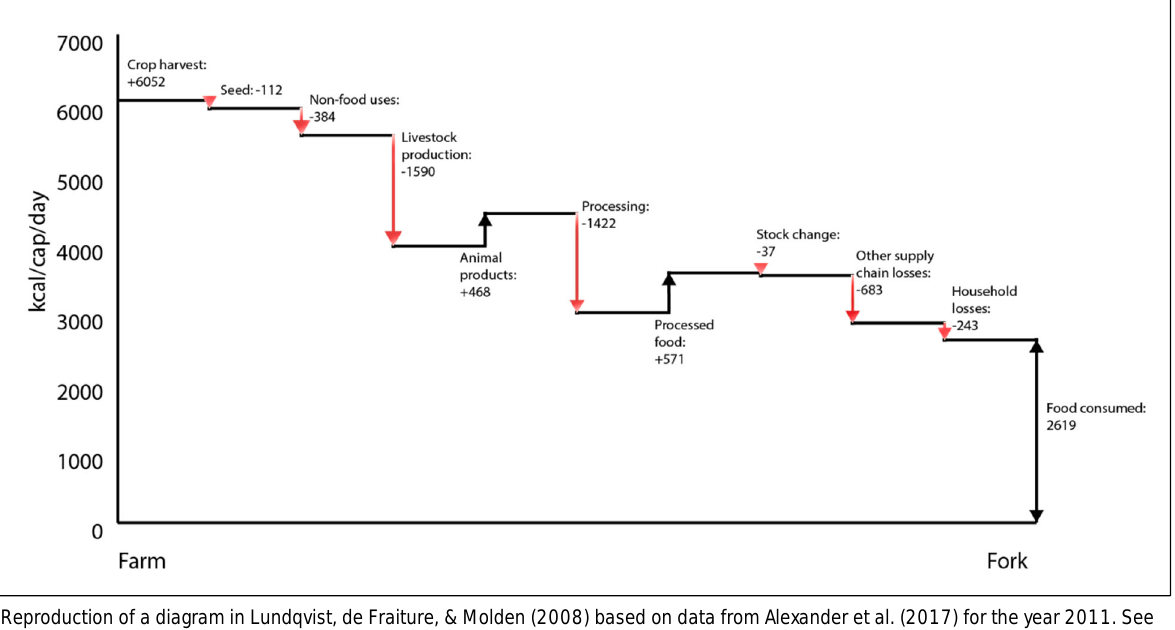
Reproduction of a diagram in Lundqvist, de Fraiture, & Molden (2008) based on data from Alexander et al. (2017) for the year 2011. See Alexander et al. (2017) for a more detailed representation in a Sankey diagram. This diagram is based on a world population of 7